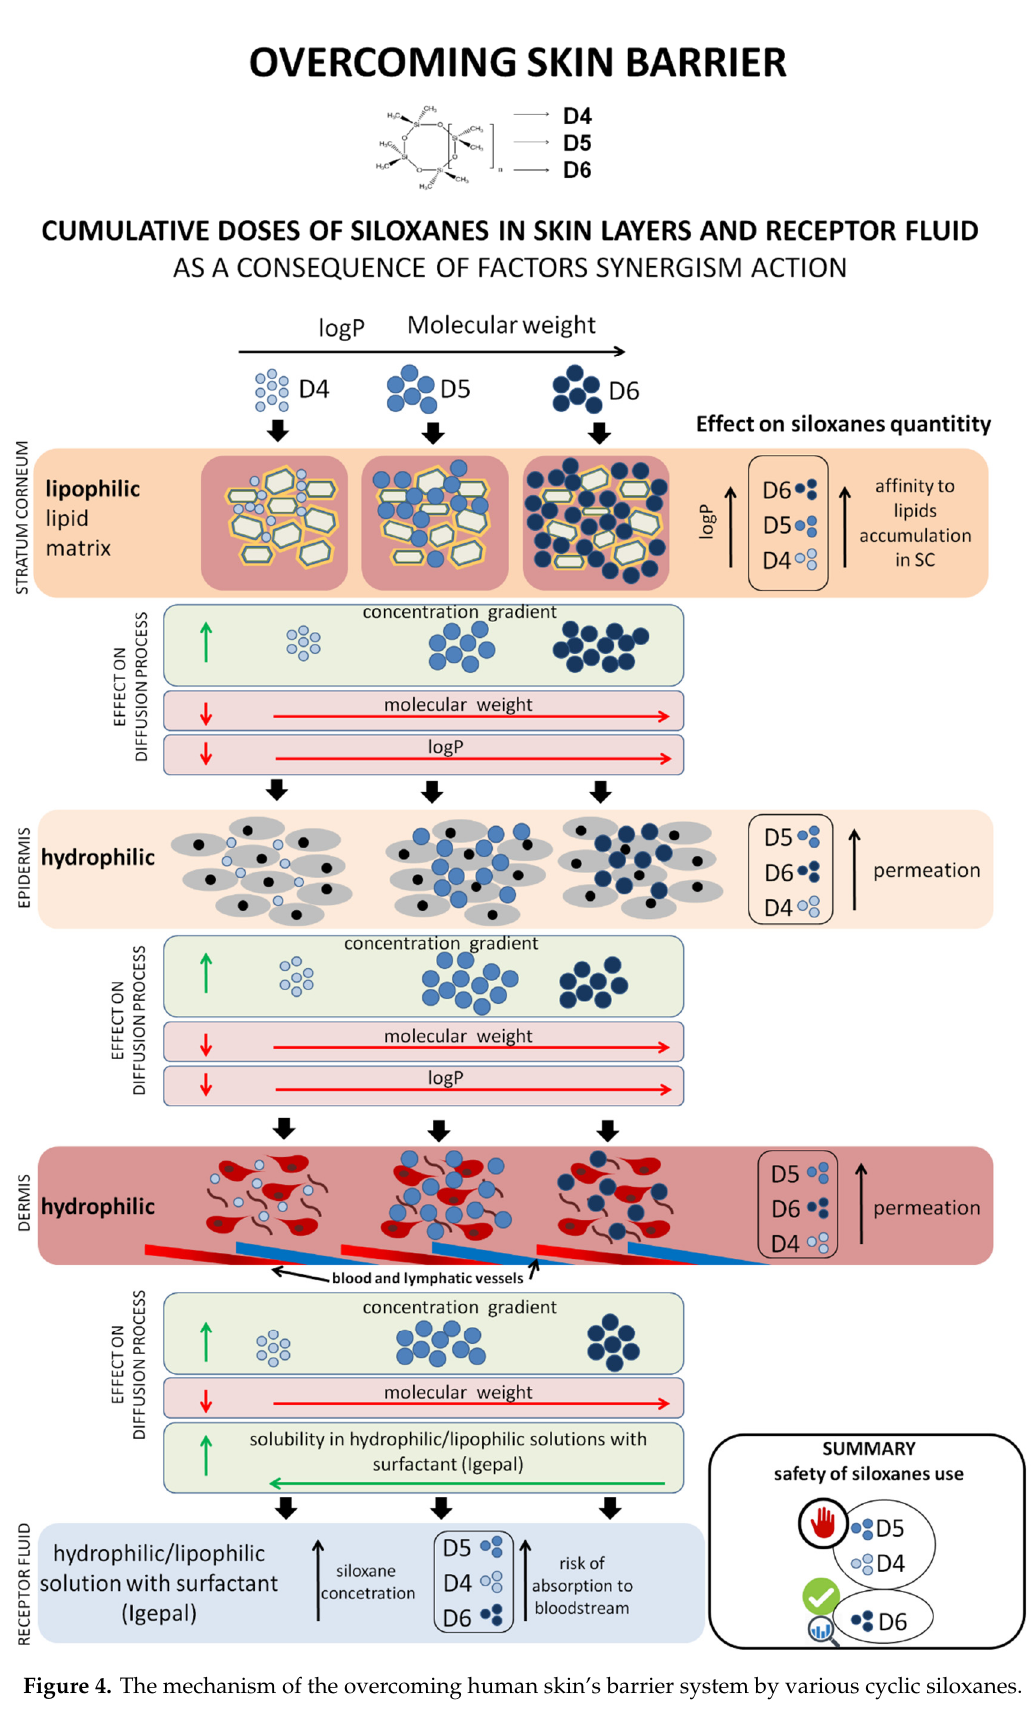
Figure 4. The mechanism of the overcoming human skin’s barrier system by various cyclic siloxanes.